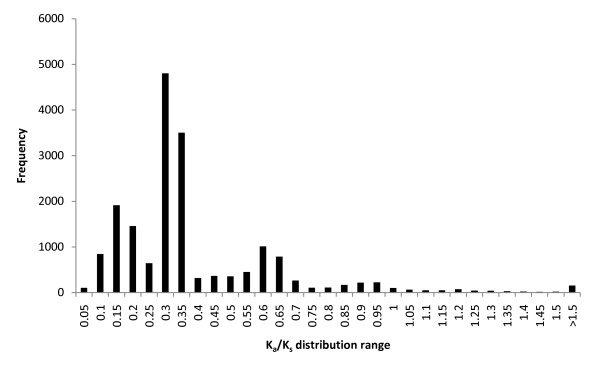
A histogram illustrating the distribution of the ratio of non-synonymous mutations to non-synonymous sites compared to synonymous mutations per synonymous sites (Ka/Ks).